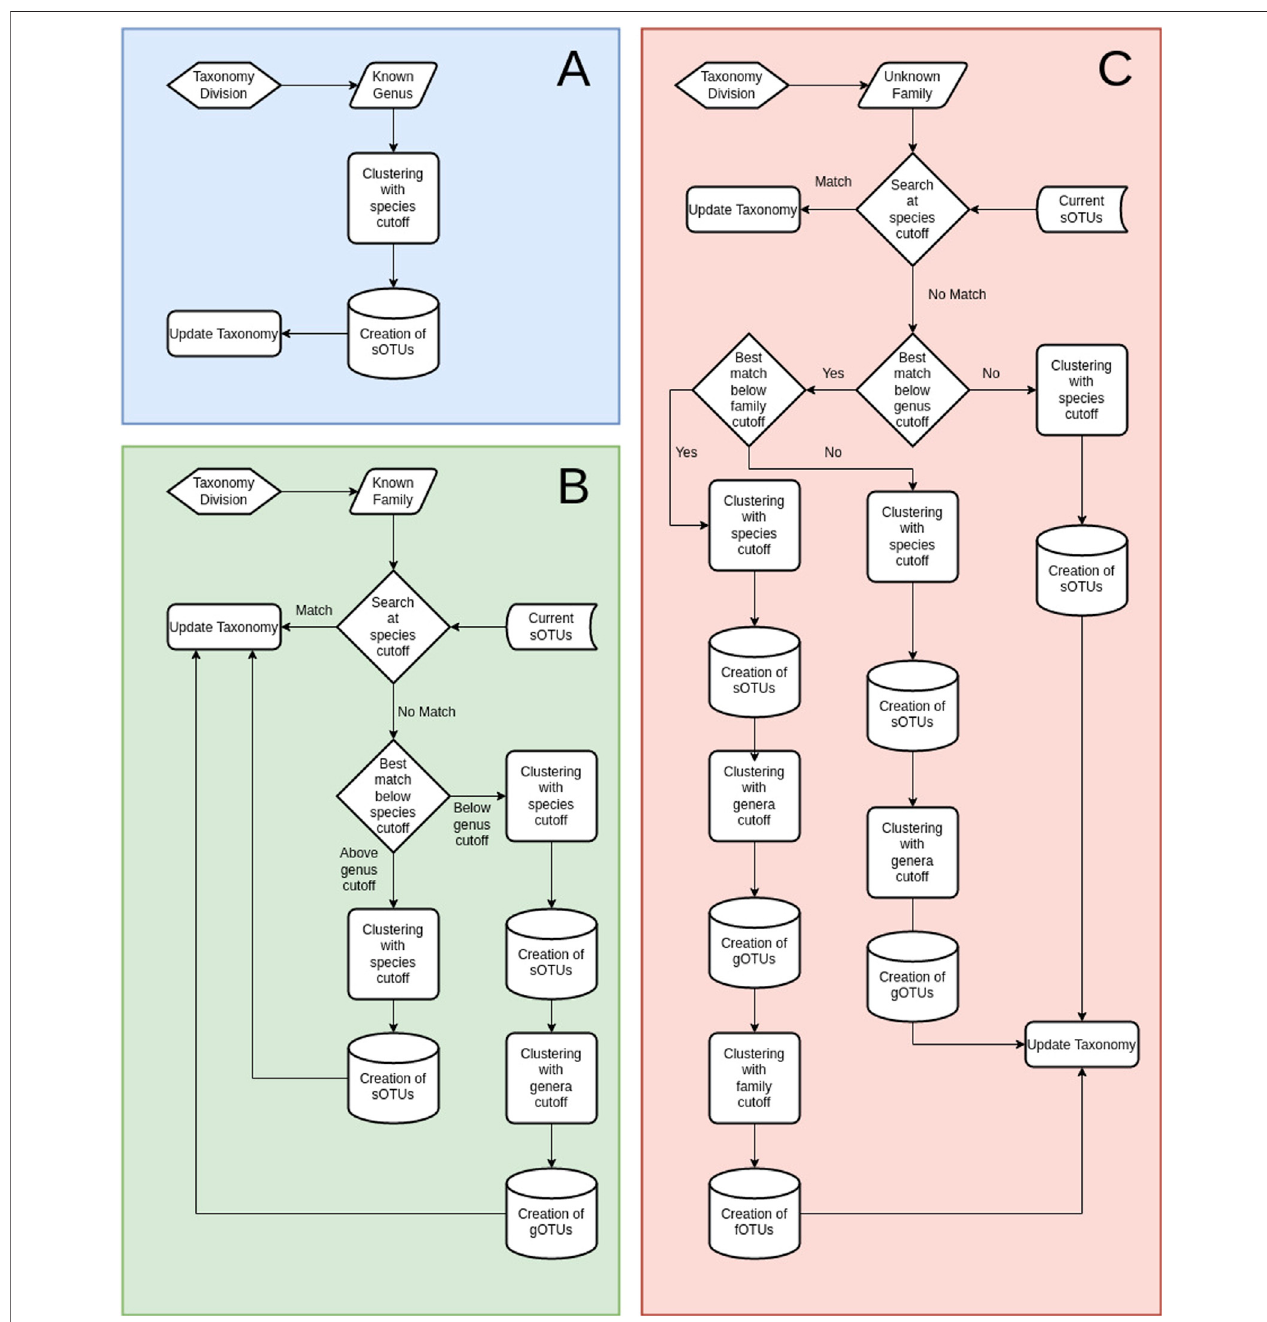
FIGURE 4 | Overview of the TIC processes. (A) Diagram of the TIC process for sequences with identi fi ed genus-level taxonomy. All sequences within each genus are used to create sOTUs. (B) Diagram of the TIC process for sequences with identi fi ed taxonomy up to the family. First step is searching for matches among those sequences and sOTUs contained within genera in the current family. Not matched sequences create novel sOTUs, which are searched for matches at the genera cutoff level (default 95%), as speci fi ed at the con fi guration fi le; if not matched again, they produce novel gOTUs. Any matched sequence gets the taxonomy of its match. (C) Diagram of the TIC process for sequences without family classi fi cation. Searching for matches among existing sOTUs at the order level. Not matched sequences createnovelsOTUs,whicharesearchedformatchesatthegeneracutofflevel;ifnotmatchedagain,theyproducenovelgOTUs.Anothersearchisconductedafterwards attheuser-speci fi edfamilysimilaritypercentage(default90%),afterward,andifnotmatchedagain,novelfOTUsarecreated.Anymatchedsequencegetsthetaxonomy of its match.